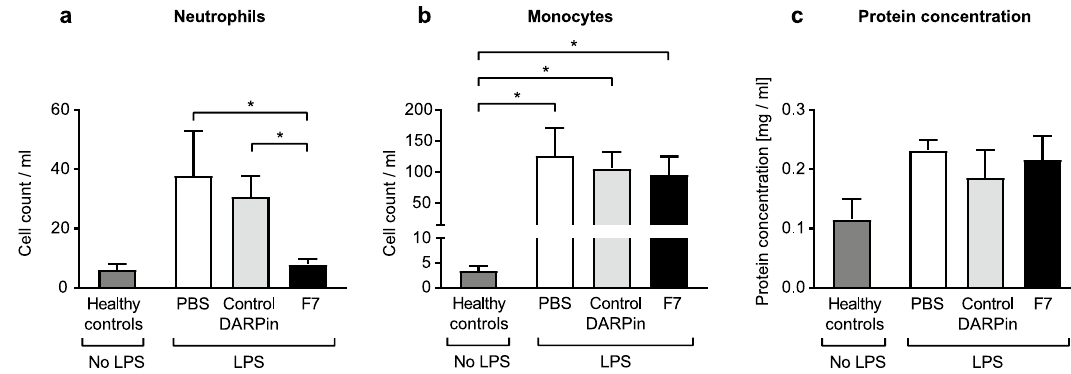
Figure 7. Analysis of bronchoalveolar lavage fluid (BALF) during the chronic phase reveals lower levels of neutrophils in mice treated with F7. BALF was harvested on day 10. ( a ) Neutrophil counts on day 10 were similar in healthy control animals compared to mice treated with F7, meanwhile neutrophil counts in both control groups remained significantly elevated. ( b ) Monocyte counts in the BALF on day 10 of the chronic phase did not differ significantly between treatment groups but were elevated compared to healthy control animals. ( c ) The protein concentration on day 10 of the chronic phase did not differ significantly between the different treatment groups. Data are presented as mean ± SEM. n = 5–10, * p < 0.01. Treatment groups were compared by an unpaired